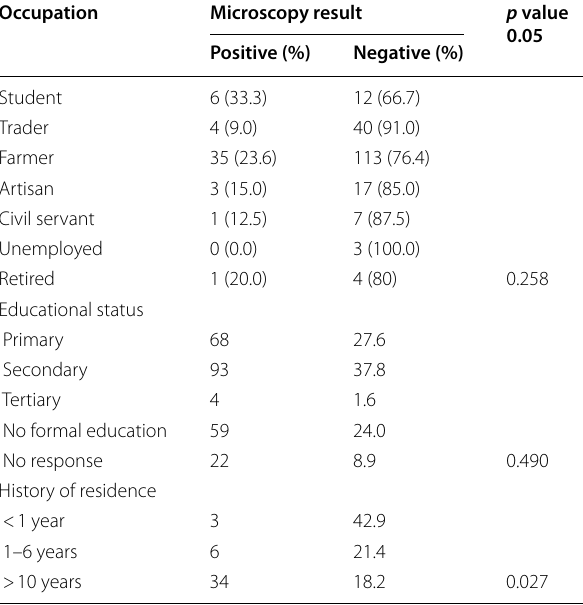
Table 4 Prevalence of lymphatic filariasis in relation to occupation, residency, name and causes in Imobi, Ijebu East Local Government Area